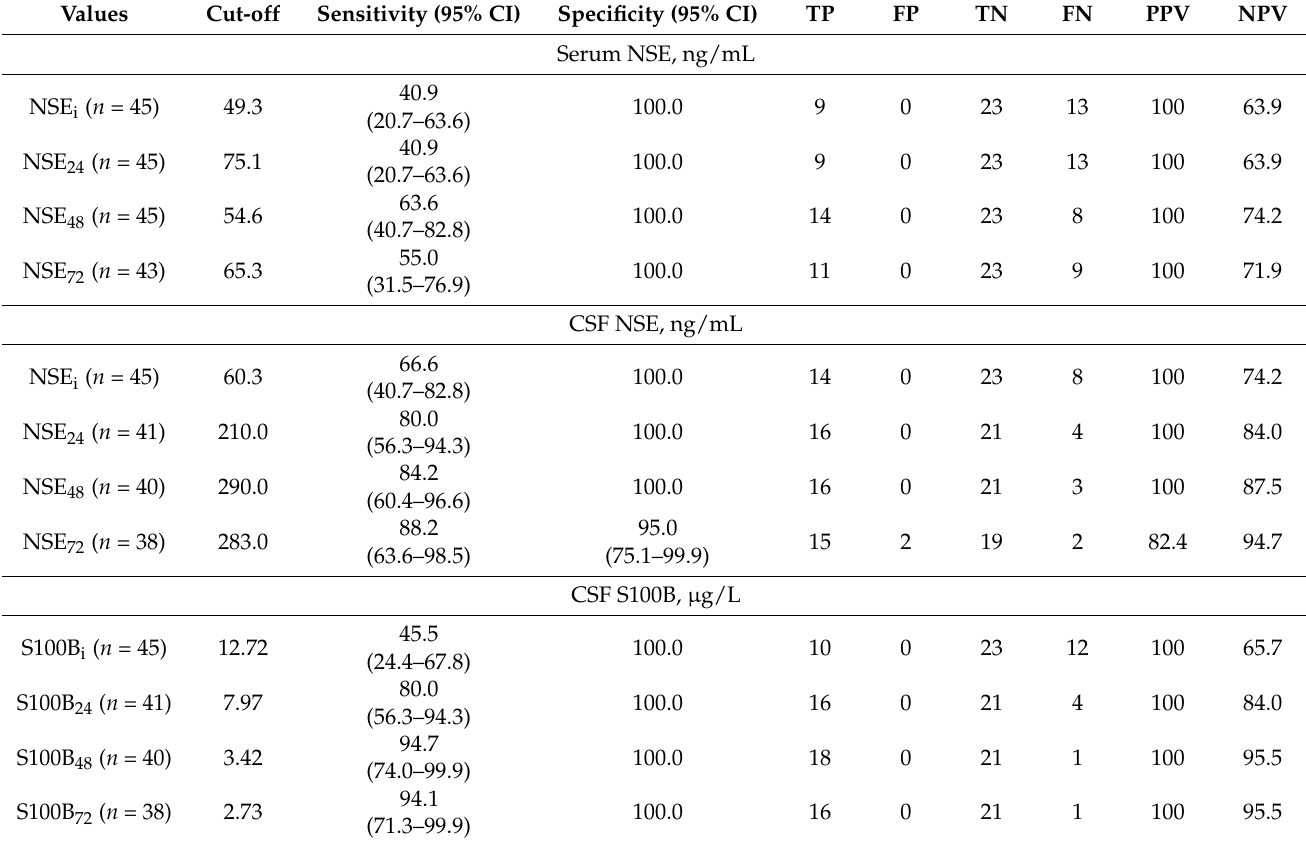
Table 3. Prognostic accuracies of NSE and S100B obtained from CSF for poor neurological outcome. Values